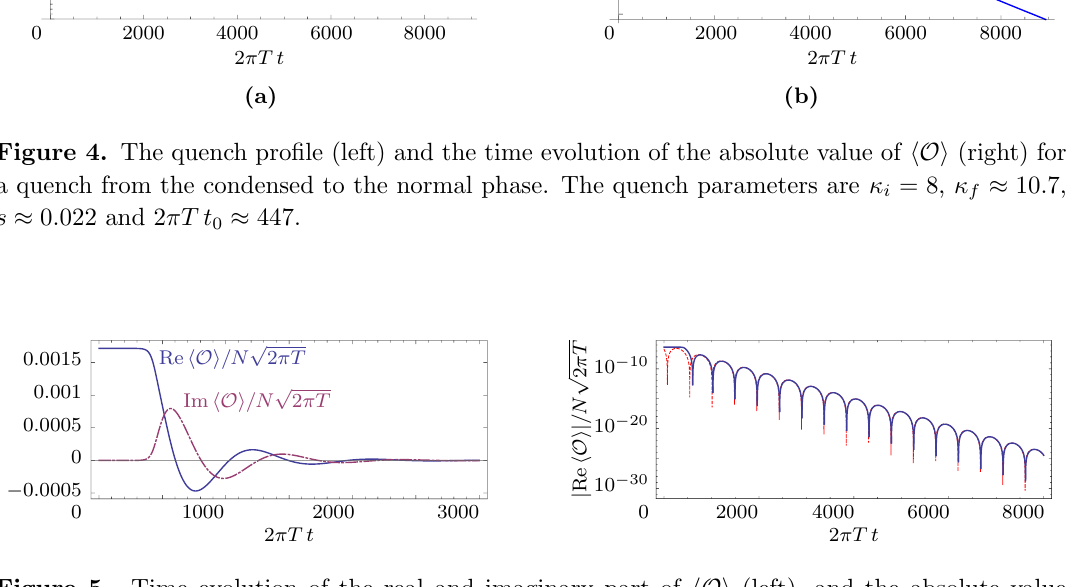
( t ). The red curve in the right plot is a 1